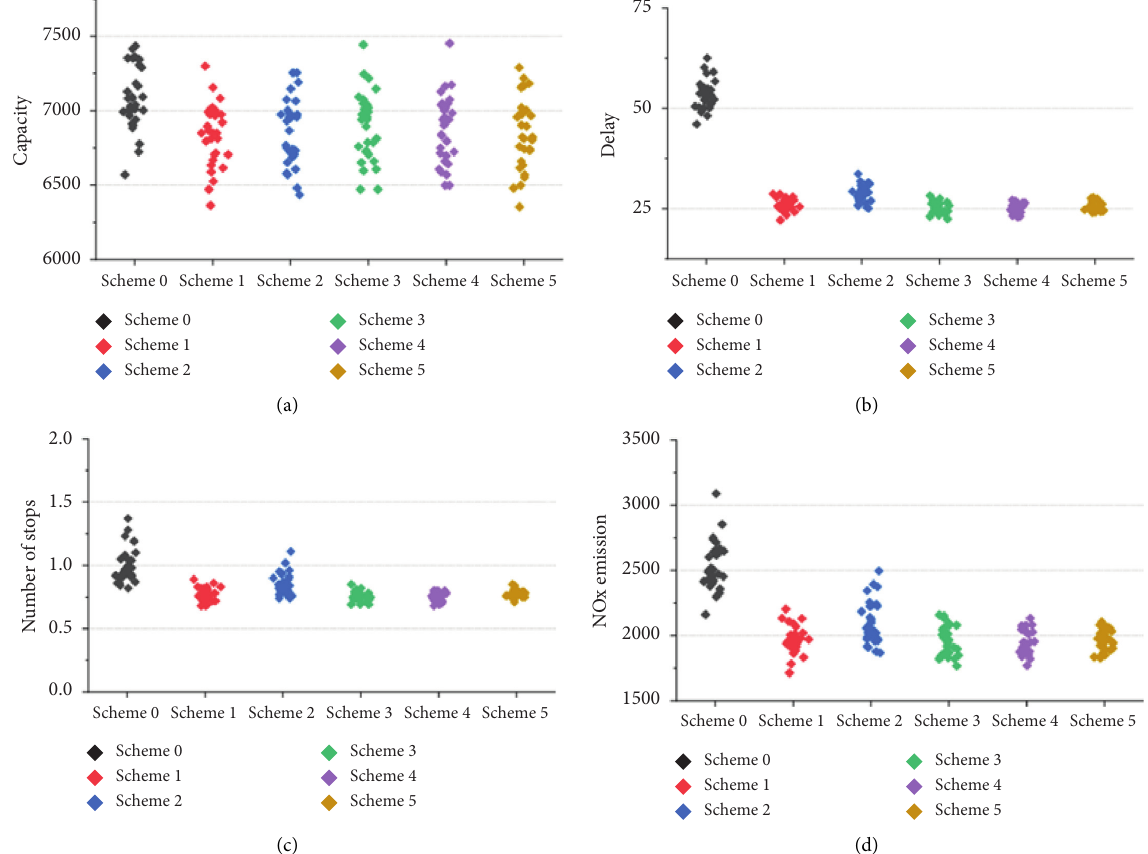
Figure 7: Simulation results of the experiments. (a) Capacity. (b) Delays. (c) Number of stops. (d) NOx emissions. Table 4: VISSIM simulation calibration results with the collected data. MAPE, mean absolute percent. Flow number Investigate capacity